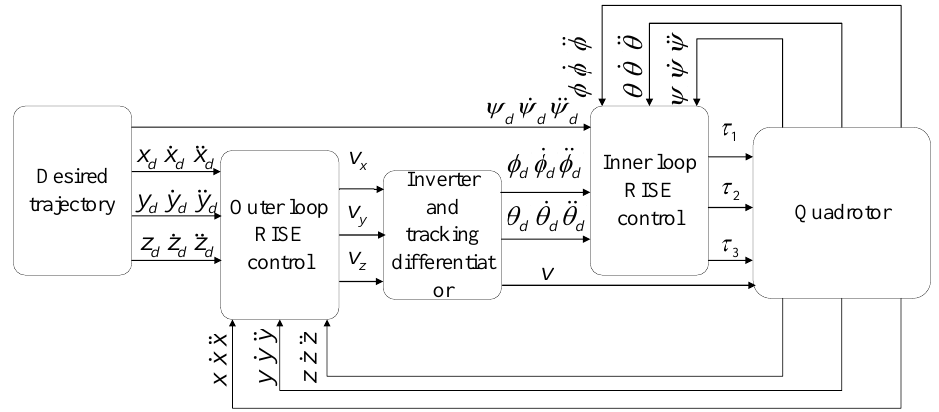
Figure 1. Leader trajectory tracking control system structure.